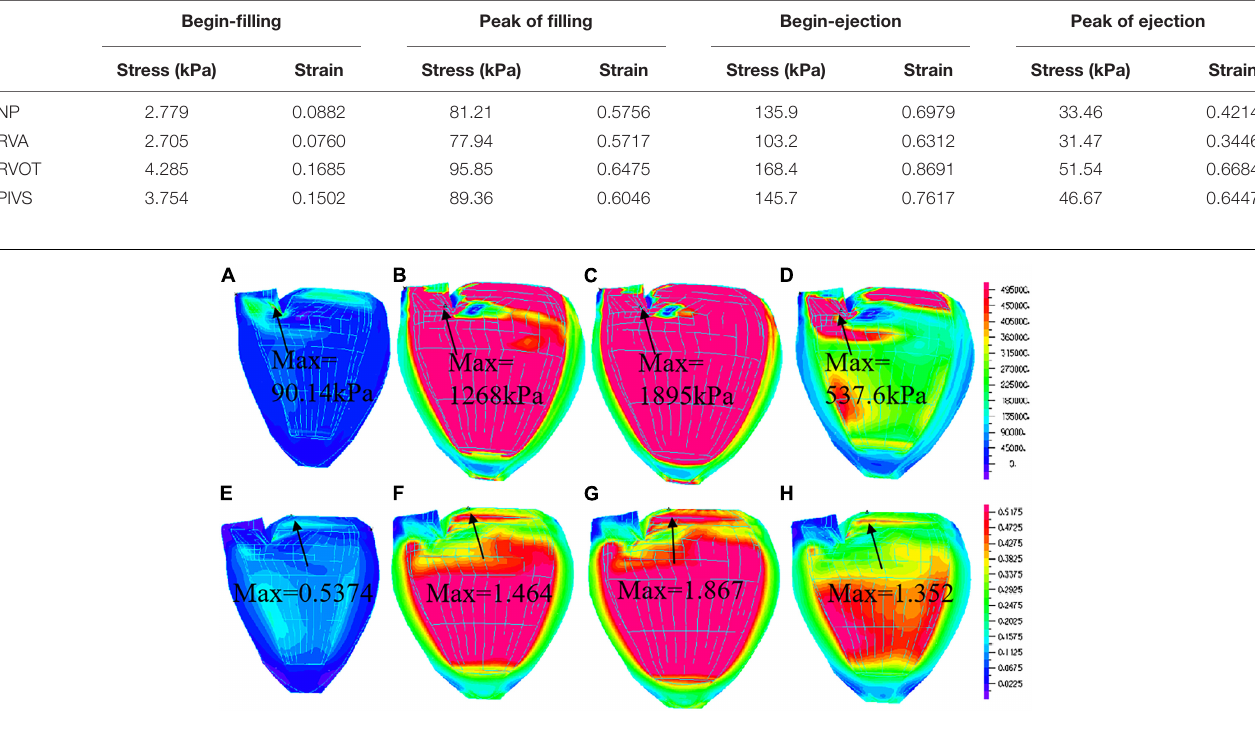
TABLE 4 | Stress and strain mean values at different times from 4 pacing models.